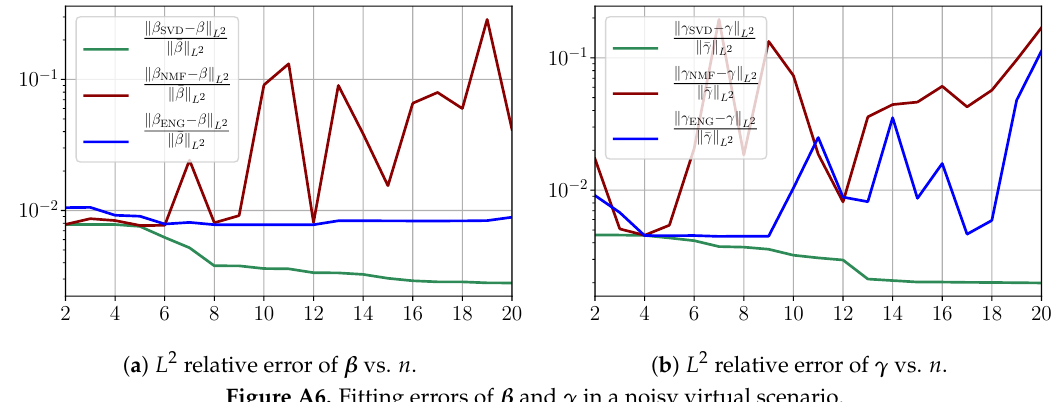
( b ) L 2 relative error of γ vs. n . Figure A6. Fitting errors of β and γ in a noisy virtual scenario.